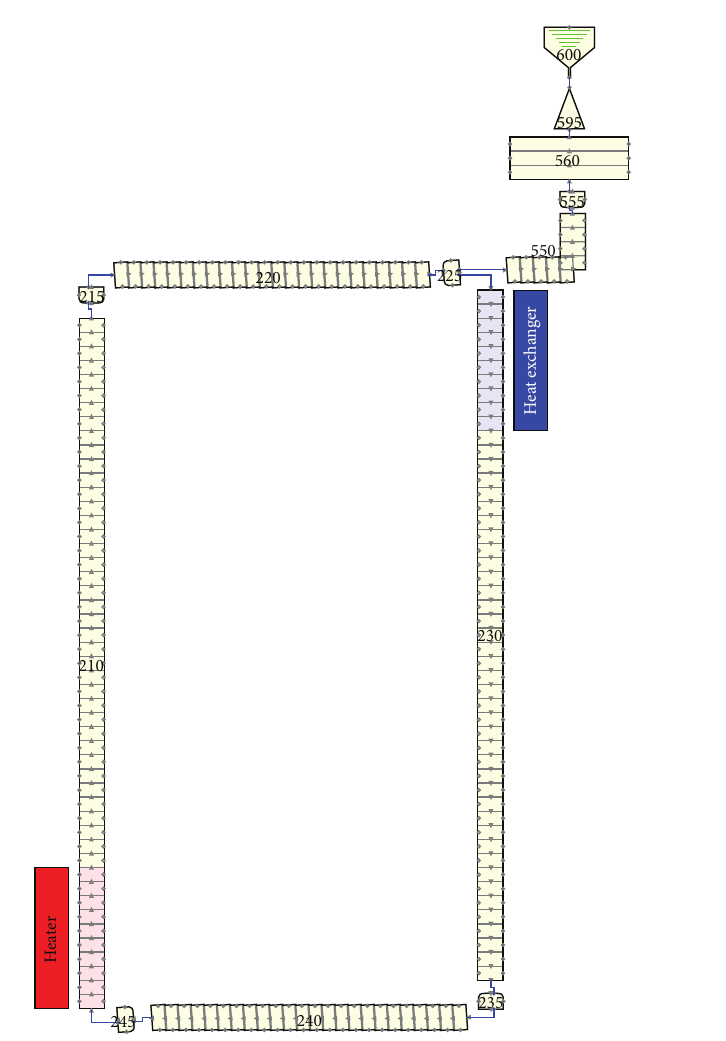
Figure 20: Lead critical parameters validity range and calculated values.